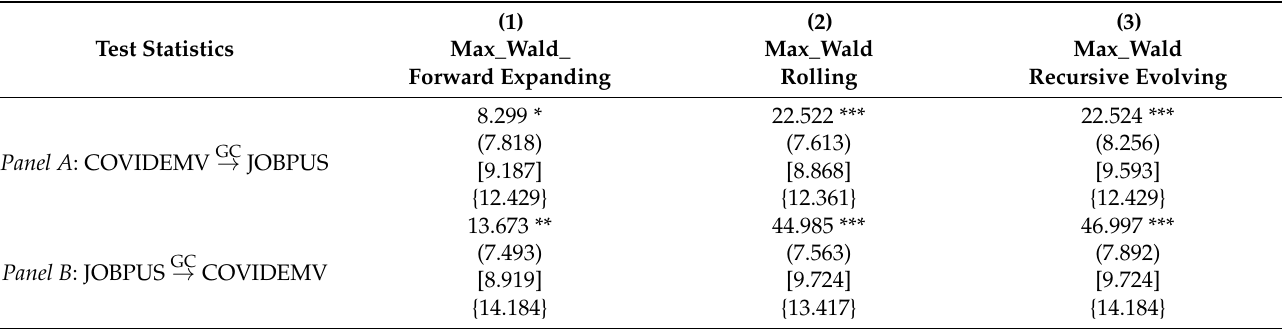
Table 4. Time-varying Granger causality between COVIDEMV and US manufacturing job postings